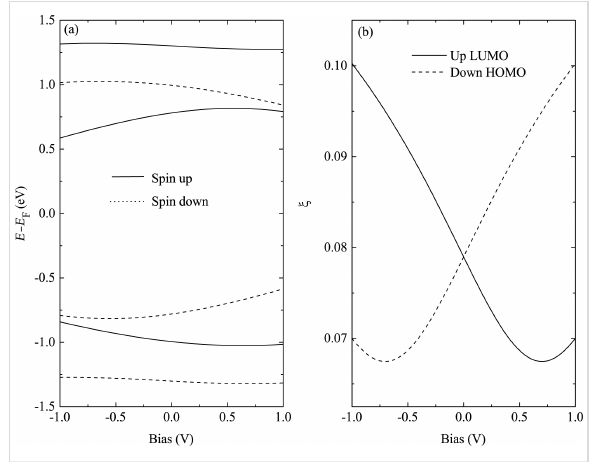
Figure 12: Bias-dependent (a) molecular eigenlevels and (b) electronic localization of the spin-up LUMO and the spin-down HOMO. Reproduced with permission from [59], copyright 2016 Else-